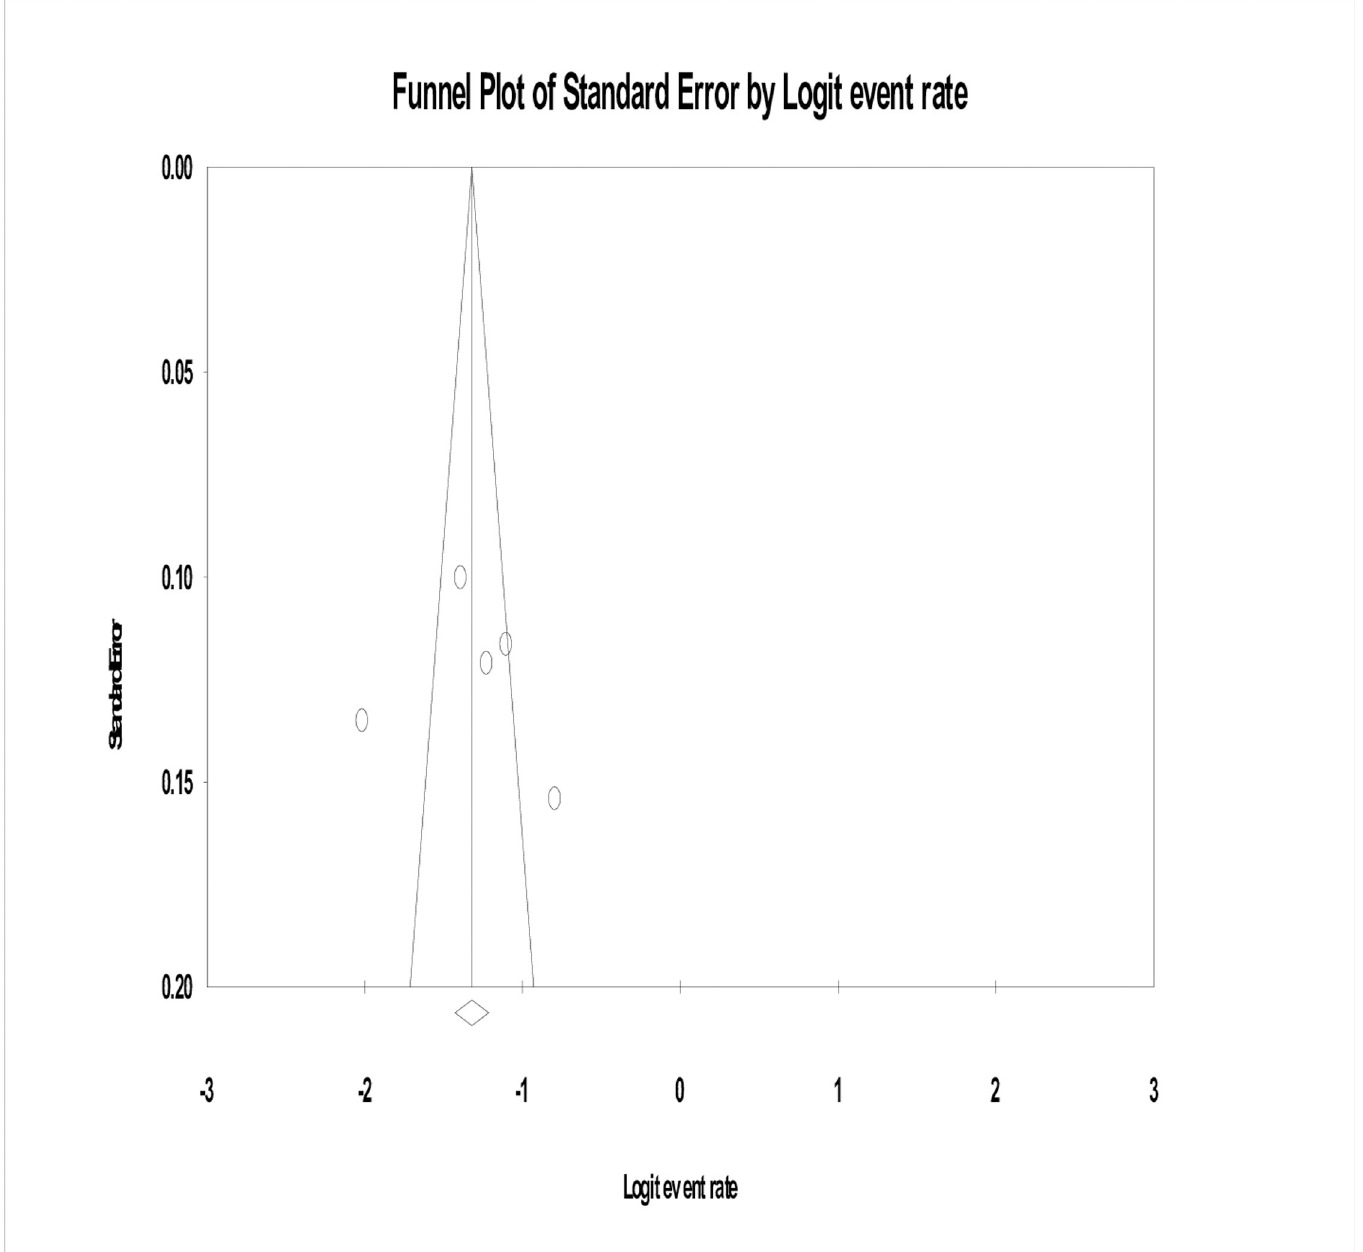
Fig 3. Funnel plot of risk of publication bias for the prevalence of antenatal depression in Ethiopia.